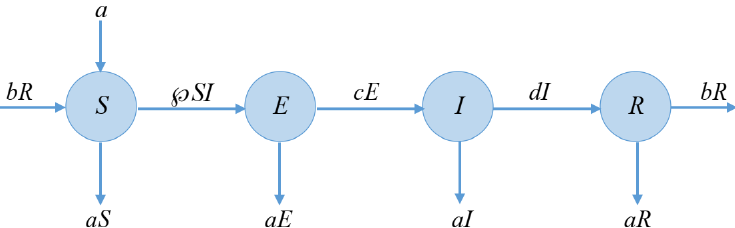
Figure 1. Block diagram for SEIR